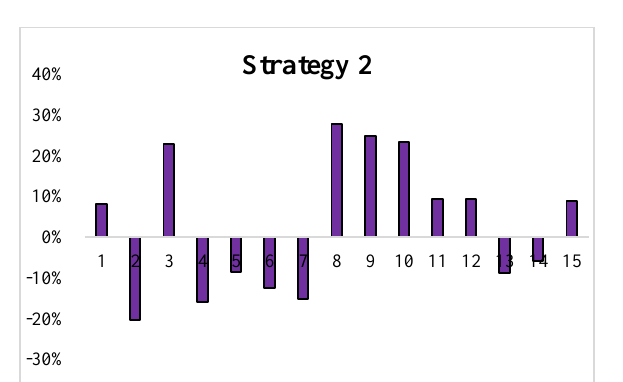
Fig3. Returns for 15 pair trades by using strategy 2 in the out-of-sample period. Implementing passive